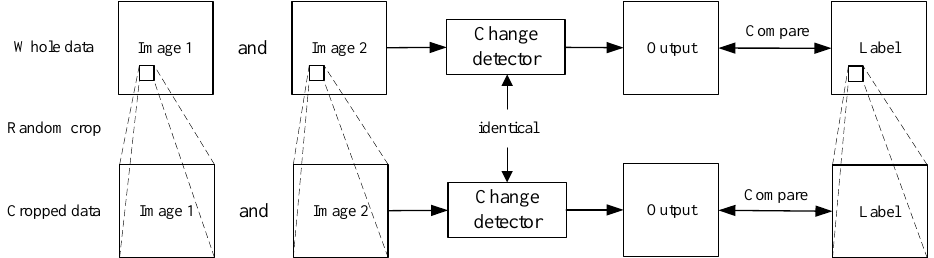
Figure 12. Schematic diagram of two parts of real data experiment. The first row indicates the experiment using the complete data and the second row indicates that we use the cropped images from the complete